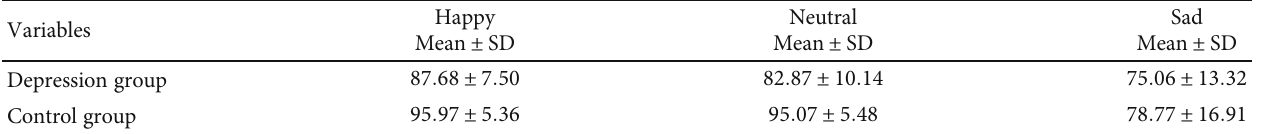
Table 2: Accuracy (%) of facial expression category in the depression group and control group ( n = 30 ).